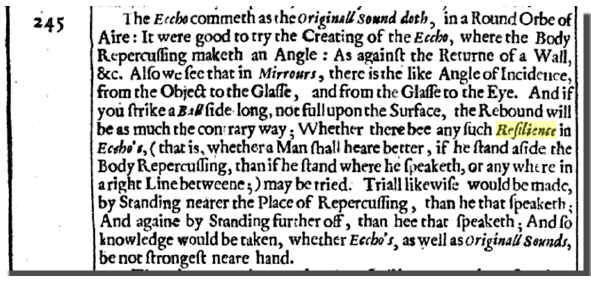
Fig. 2. Resilience in the Sylva Sylvarum of Francis Bacon.